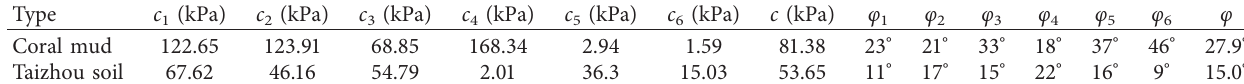
Table 4: Coulomb-molar parameters of coral mud and Taizhou